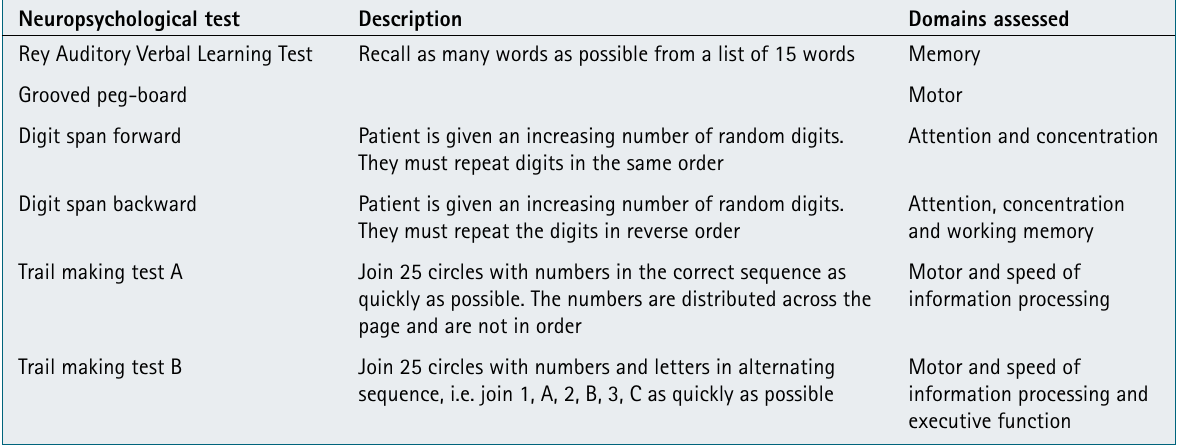
taBle ii. Selected neUROPSYcHOlOGical teStS and tHe dOmainS